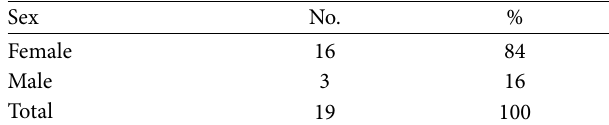
Table 2: Distribution by sex.